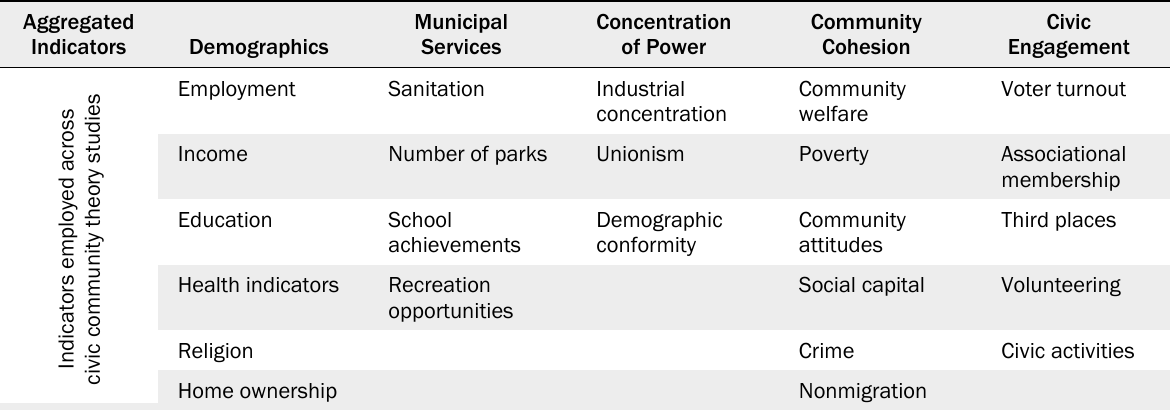
Table 1. Aggregated Civic Community Theory Indicators